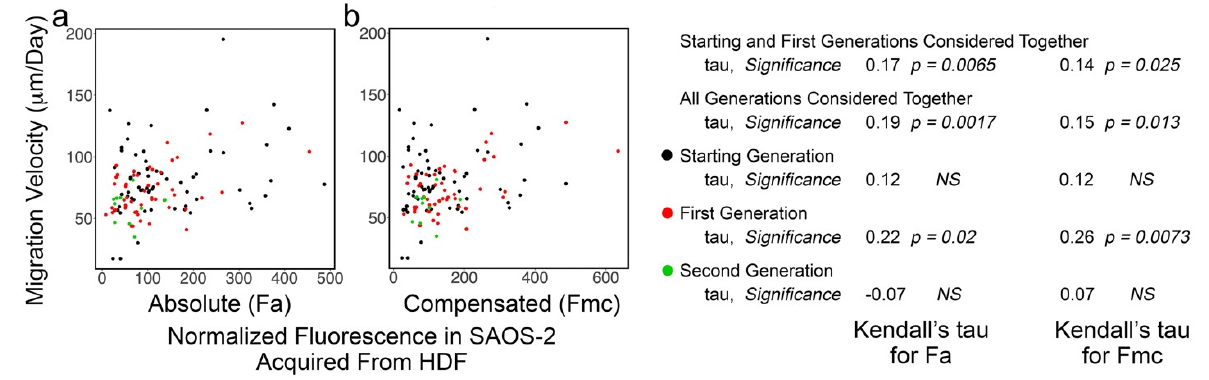
ments are in italics to aid visual interpretation, and exact values for p are given when these were available.